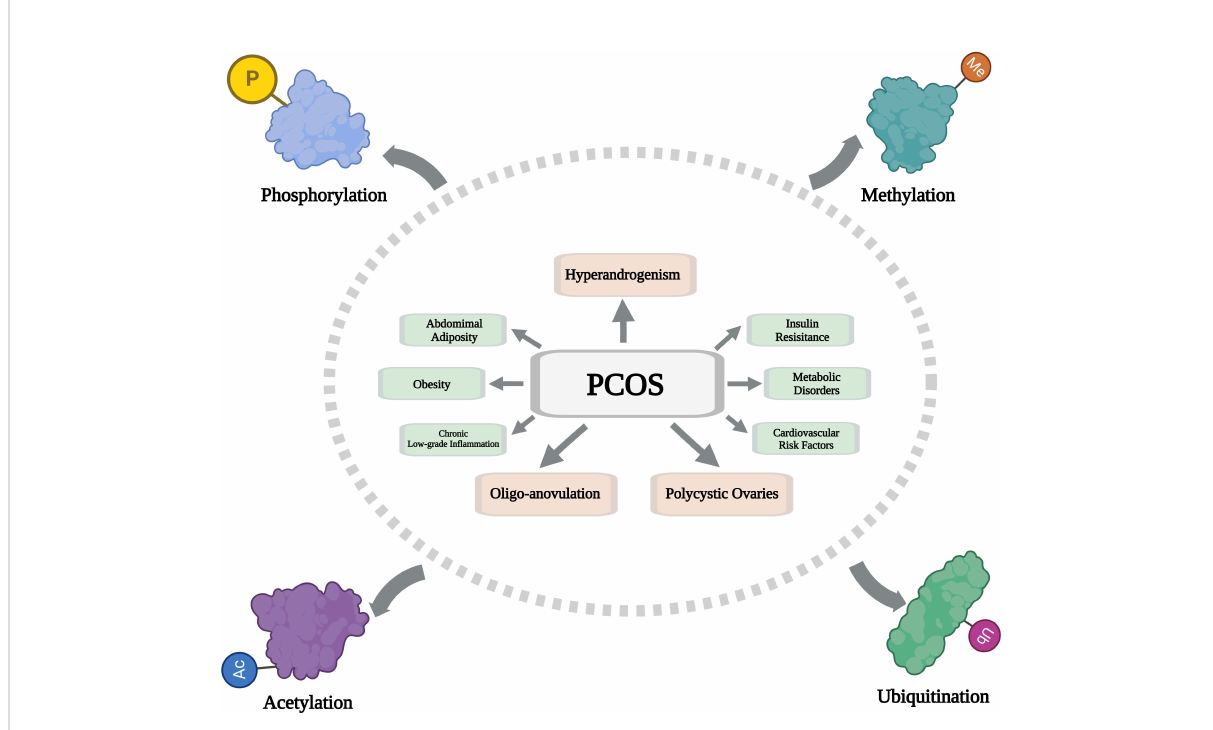
FIGURE 1 Schematic diagram showing the composition and regulatory mechanism of PTMs in PCOS. (Created with